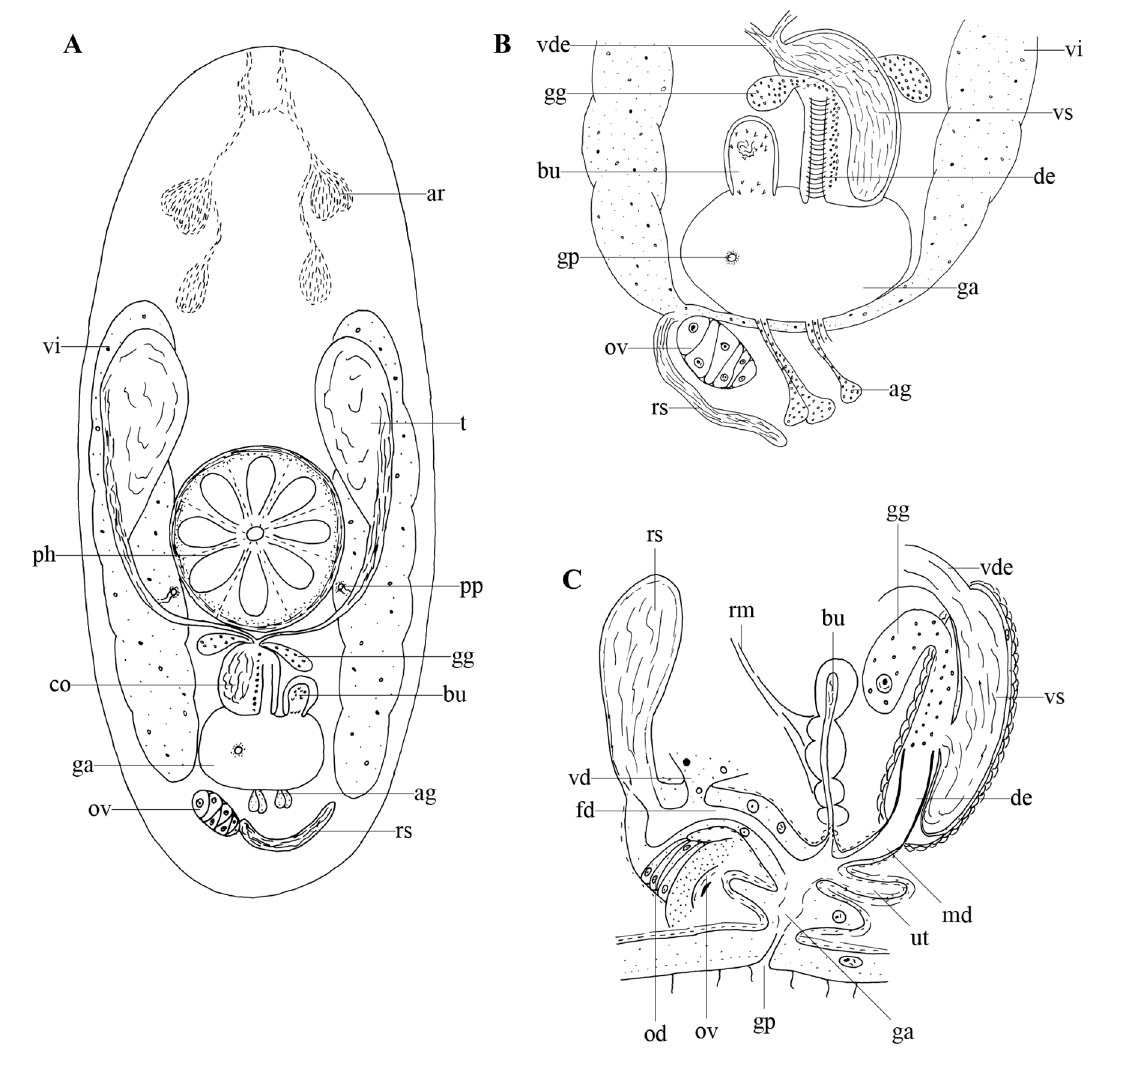
Fig. 6. Chorizogynopora italica Kolasa, 1981. A . Internal organisation of a live specimen. B . Organisation of the genital system of a live specimen. C . Reconstruction of reproductive organs based on sagittal